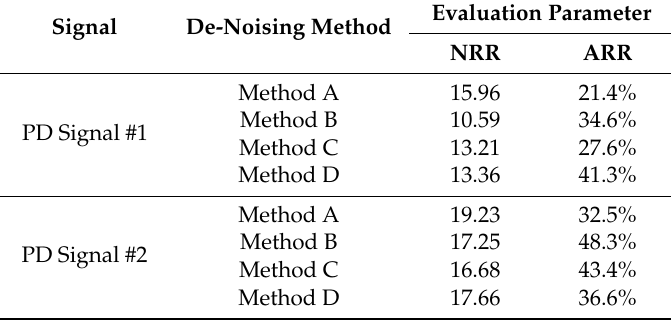
Table 6. De-noising evaluation parameters of field detected